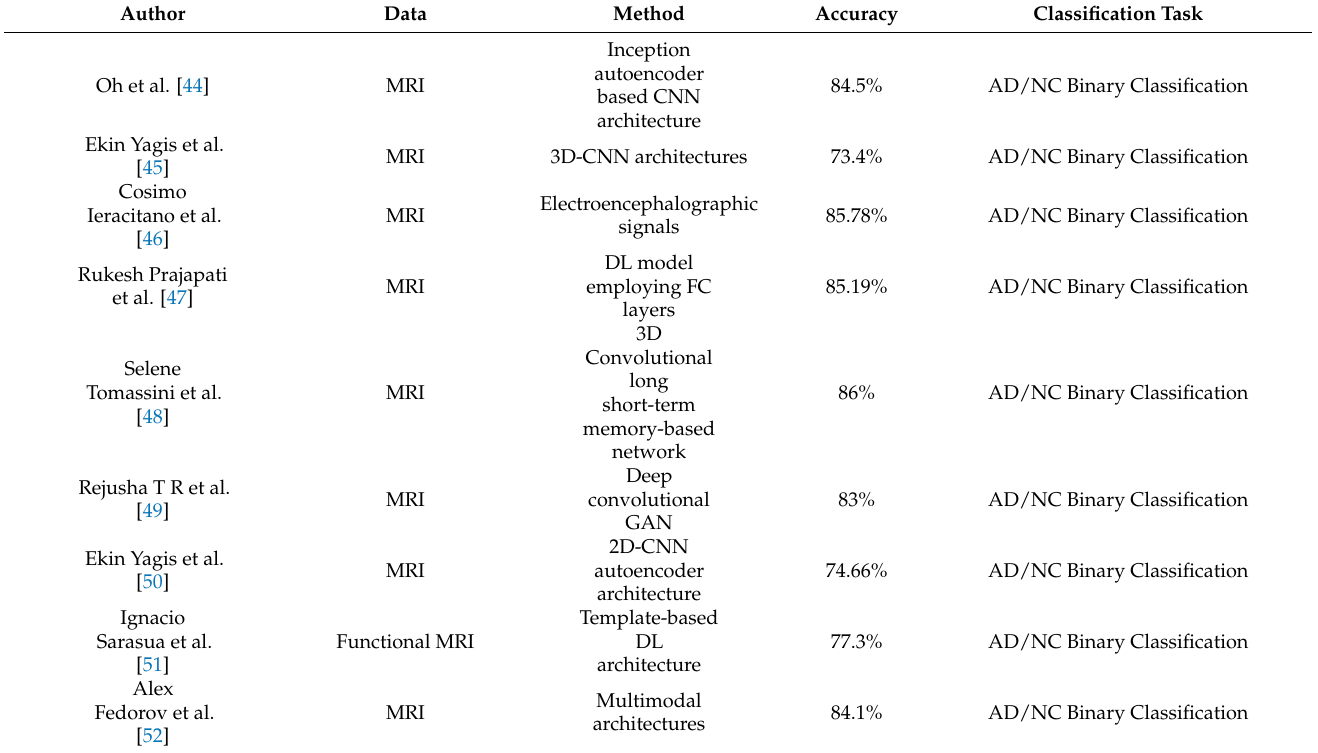
Table 6. Comparison with the state of- the